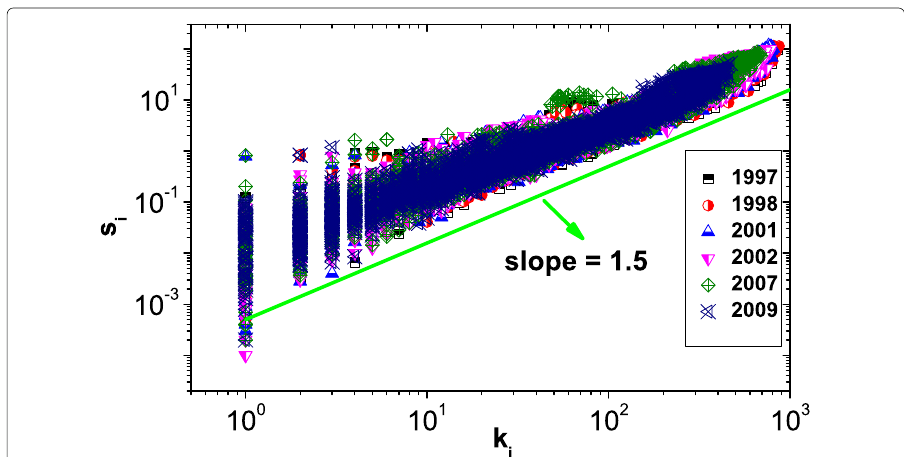
Fig. 3 Strength s as function of the degree k of nodes. The line shows that the real data follow a power law behavior with an exponent β ≈ 1.5